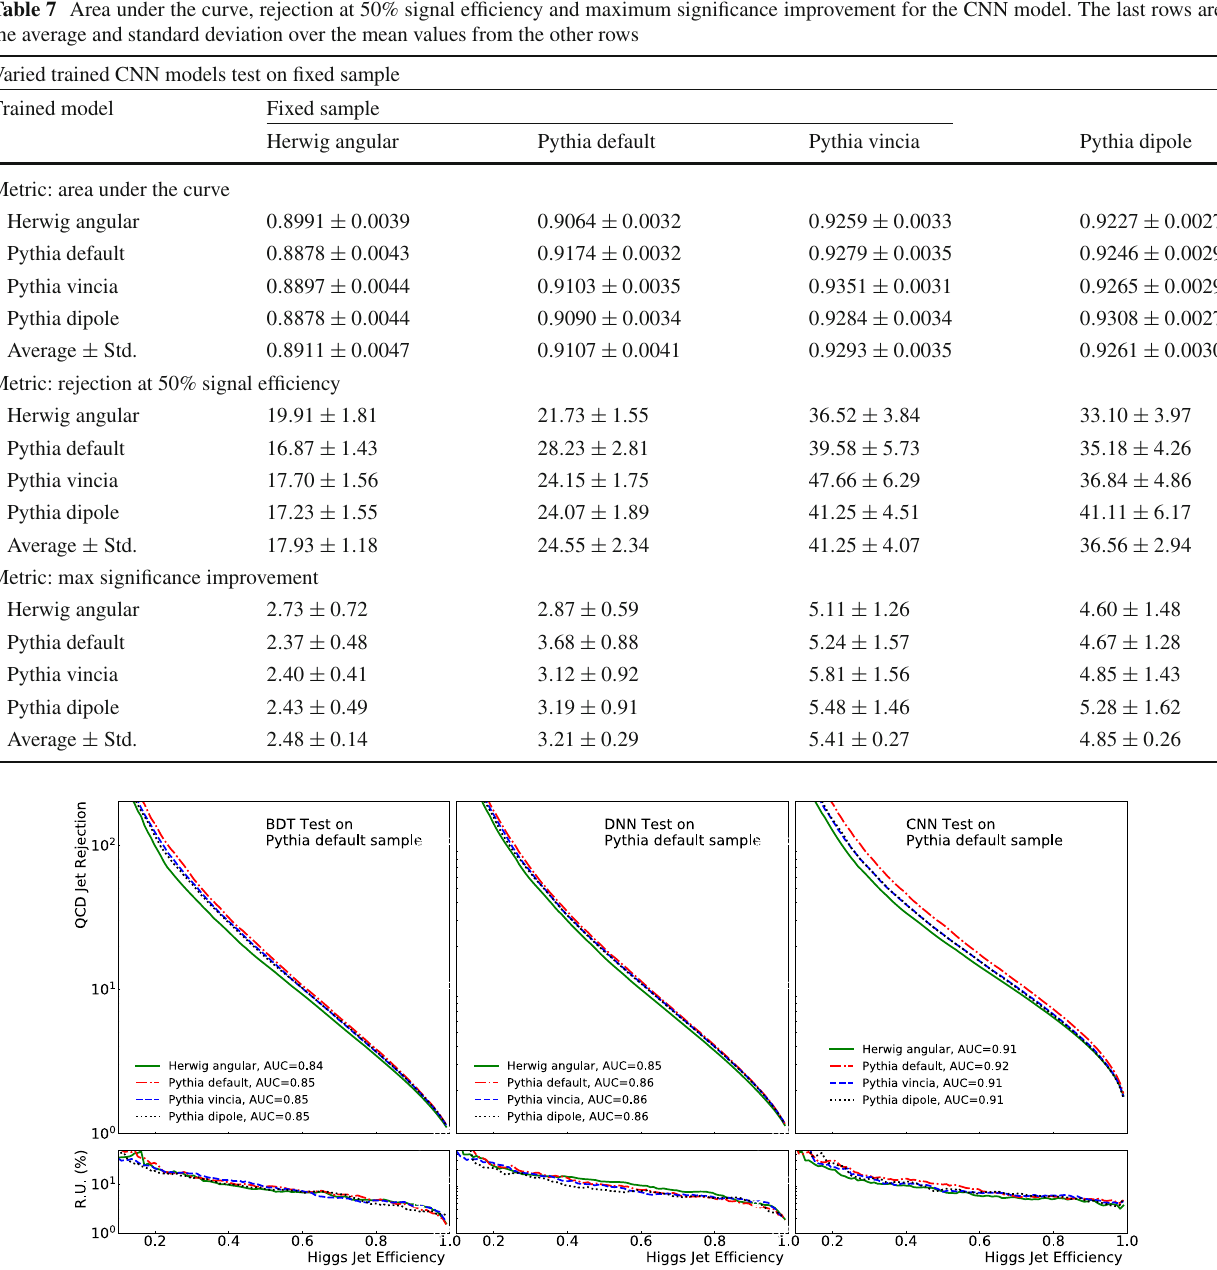
Fig. 8 The QCD rejection (inverse QCD efficiency) as a function of the Higgs jet efficiency for classifiers applied to Pythia default sample from four PSMC algorithms. The bottom panel shows the relative